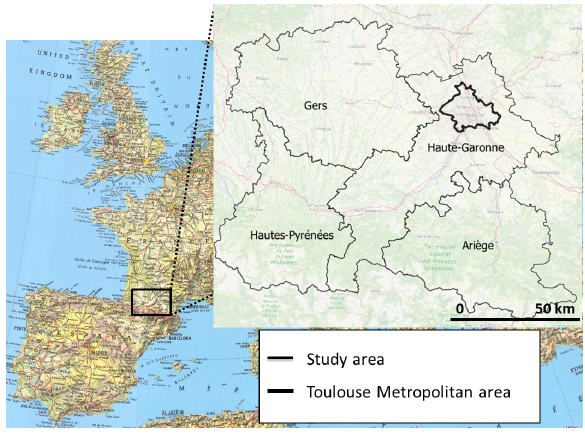
Figure 1. Study site